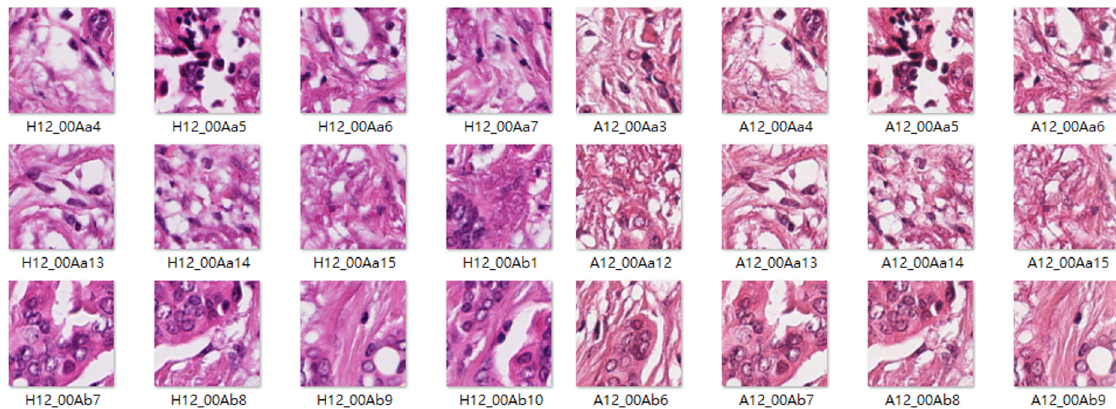
Figure 9. Example images from the Mitos-Atypia-14 dataset.